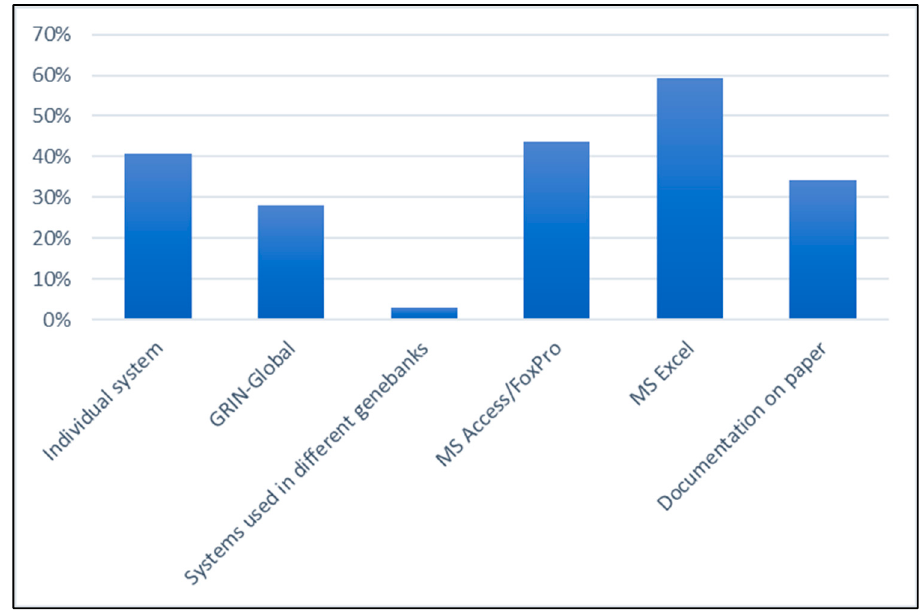
Figure 1. Overview of the management systems used in various genebanks. Different systems are often used depending on the type of data. Therefore, multiple answers were possible.